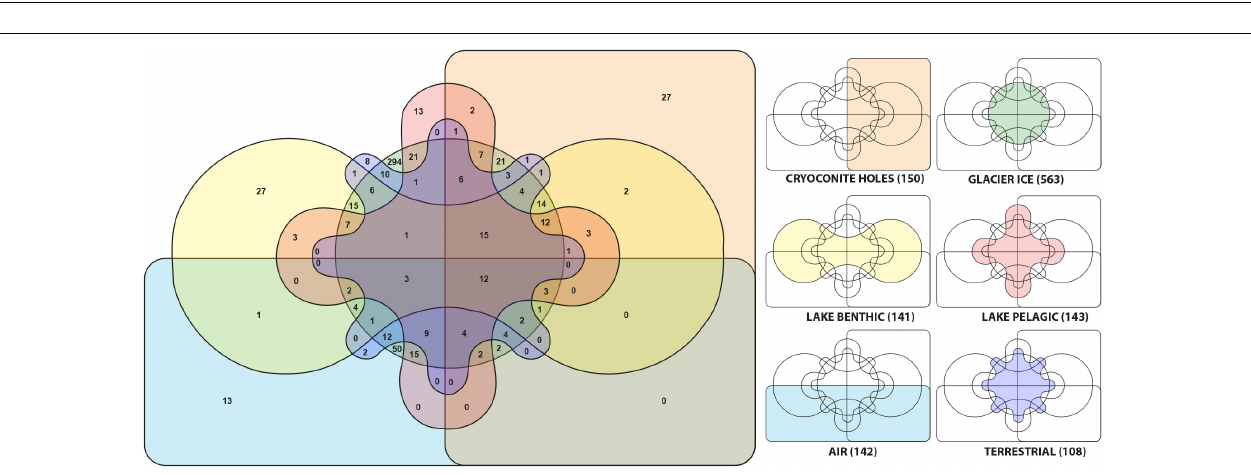
FIGURE 7 | Genera from six different habitats are displayed in a Venn-diagram. For clarification, the colors and positions of each habitat are separately shown as mini diagrams. The numbers in brackets indicate the number of genera at each location.